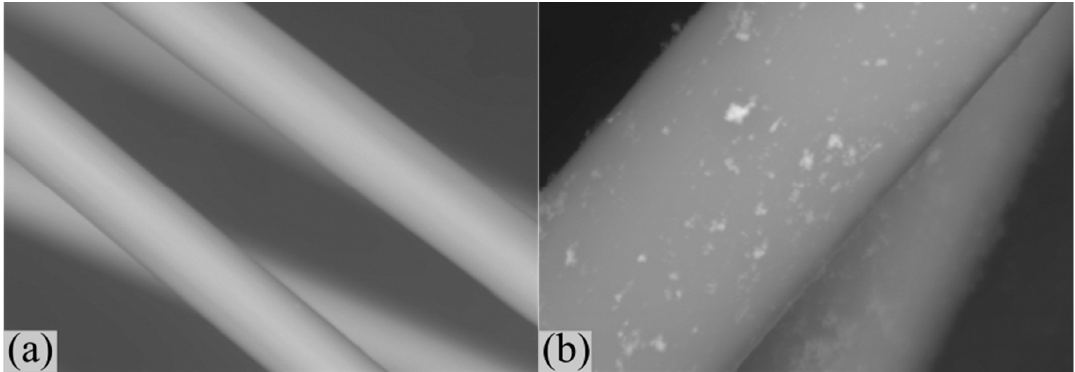
Figure 7. SEM images of ( a ) rCFs and ( b ) rGFs at 4k magnification.